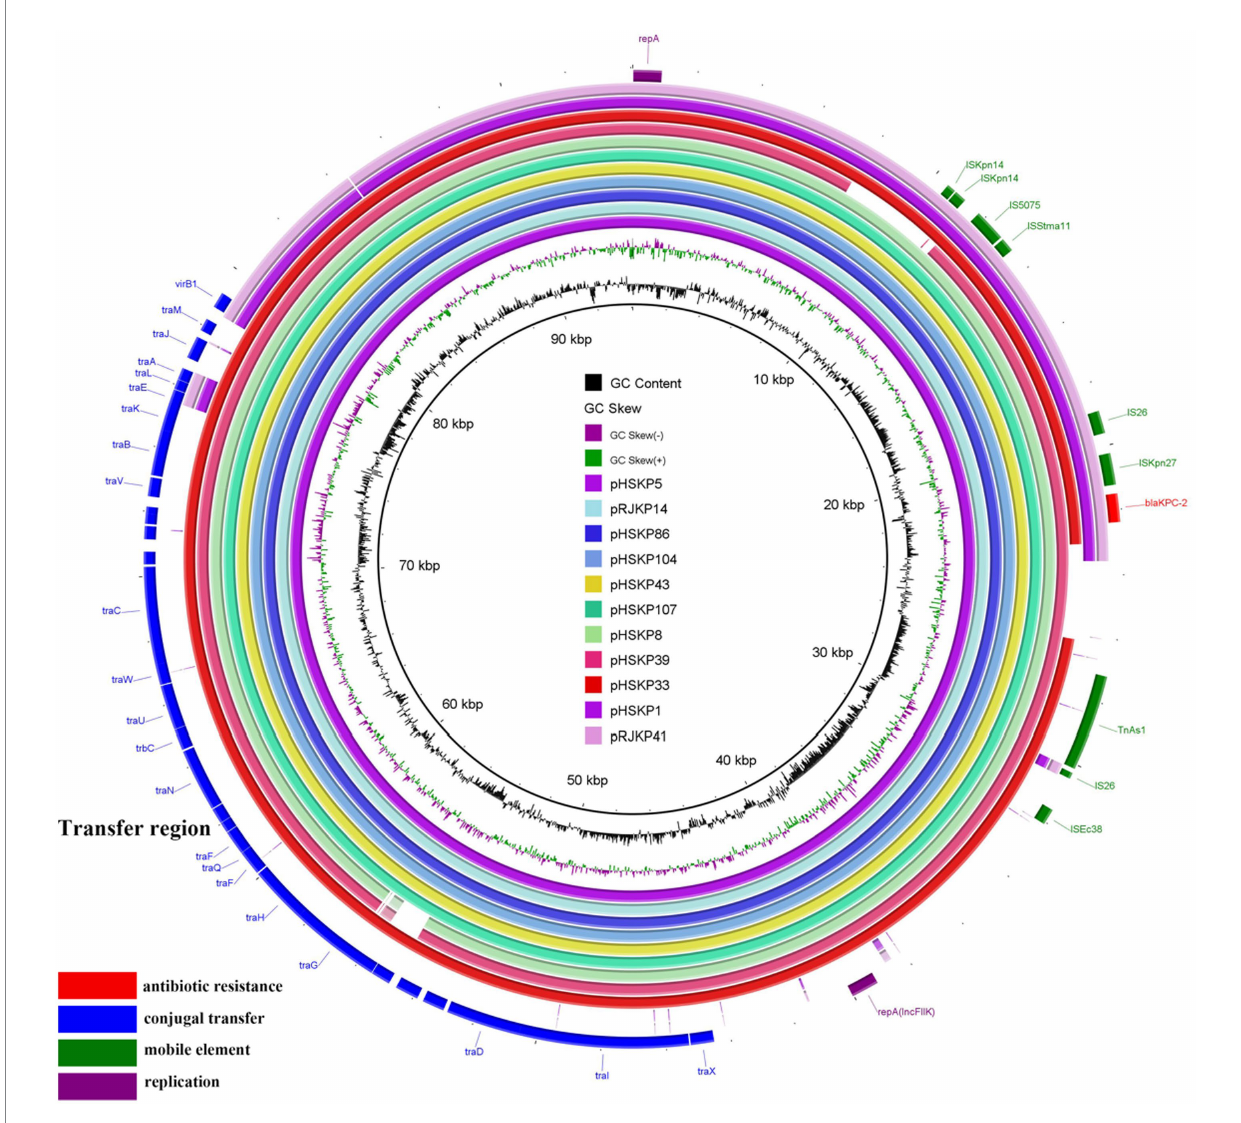
FIGURE 2 Comparative analysis of the nine IncFII K34 plasmids and two IncFII(PHN7A8) plasmids. The outmost purple and pink circles represent the two IncFII(PHN7A8) plasmids which showed low homology with IncFII K34